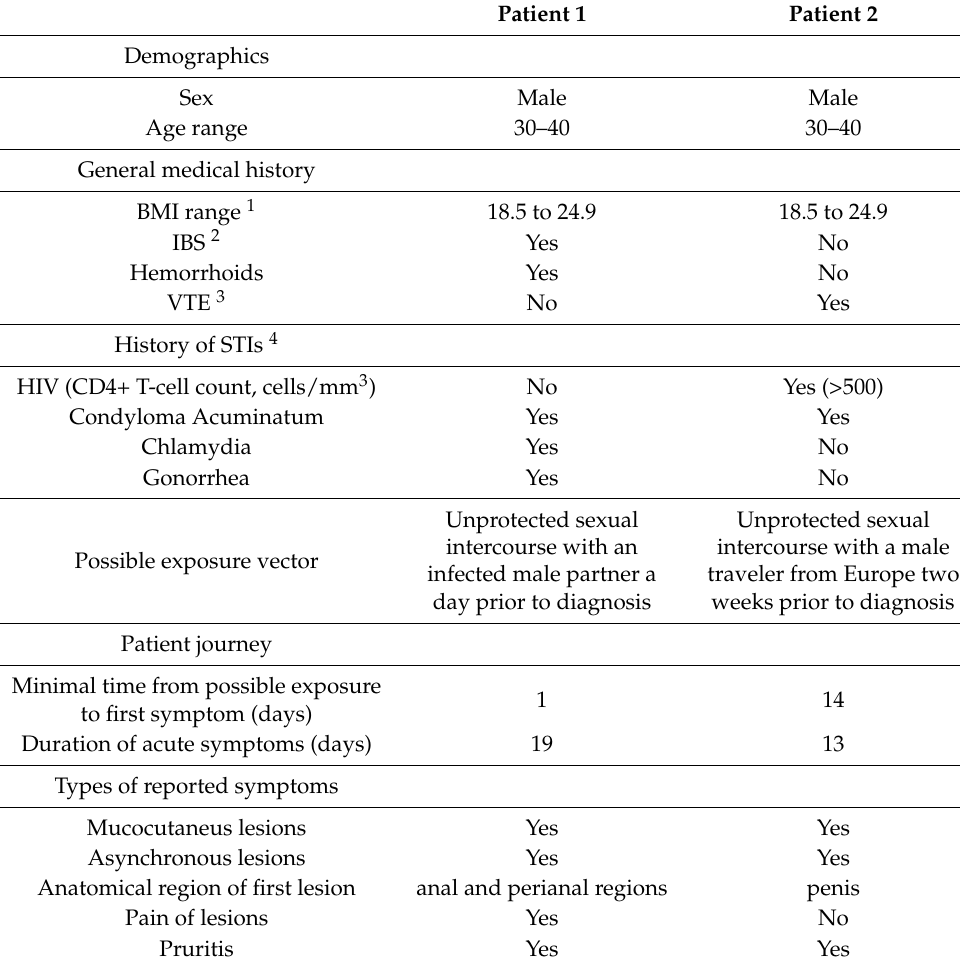
Table 1. Summary of patient